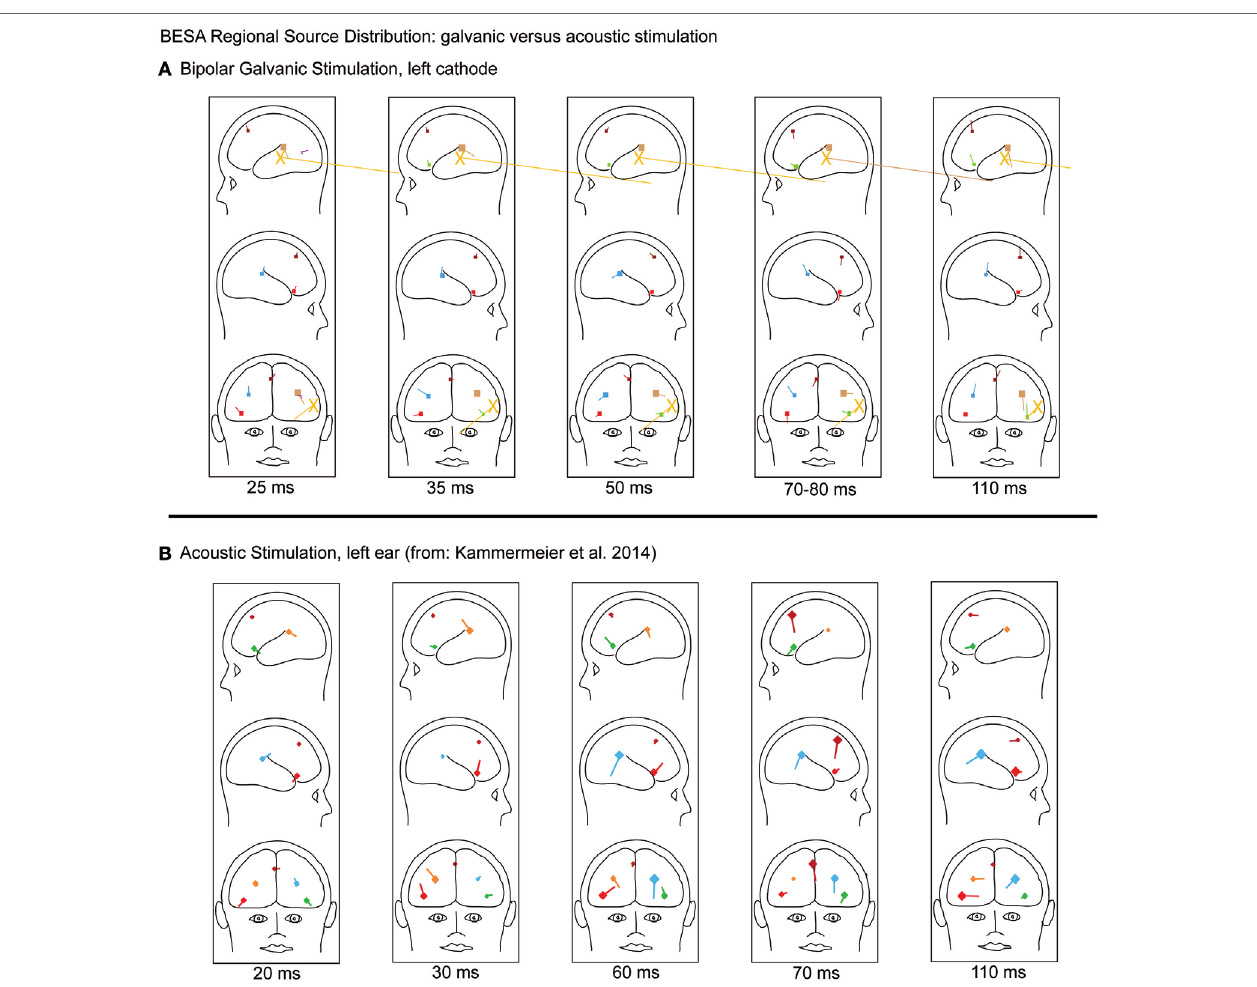
FigUre 1 | (a) Evoked cortical potentials in five regional sources (frontal source FV dark red; right anterior insula light red, left anterior insula light green; right posterior operculum light blue, left posterior operculum brown) of grand averaged data of 14 patients during left-sided bipolar galvanic vestibular stimulation in discrete source analysis brain-evoked source analysis. The orange large dipoles marked with X represent the combined bilateral bipolar capacitative effects of the galvanic pulse removed with principal component analysis. (B) Comparison to regional source dipoles evoked by acoustic vestibular stimulation in our previous study, referenced the first time as (8) in 2014. They were directed differently even in those potentials shown to have equivalent potential latency and location (70 ms in FV and 110 ms in all shown sources), indicating different activated cortical patches in the respective functional